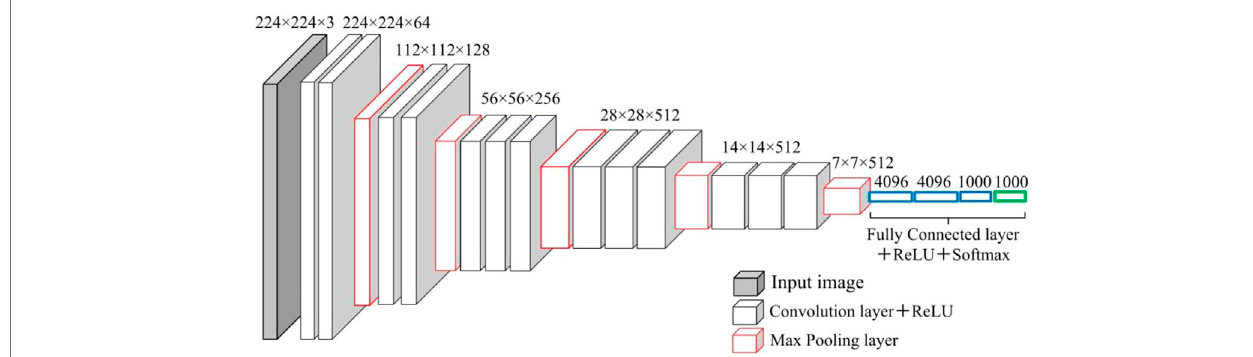
FIGURE 2 | Schematic diagram of VGG16 convolutional neural network.